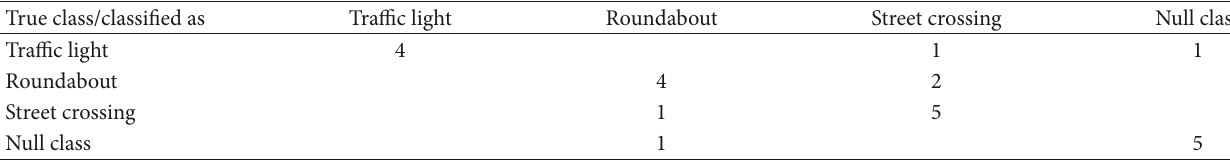
Table 9: Confusion matrix using total variation distances and 𝑘 -NN ( 𝑘 = 3 ).